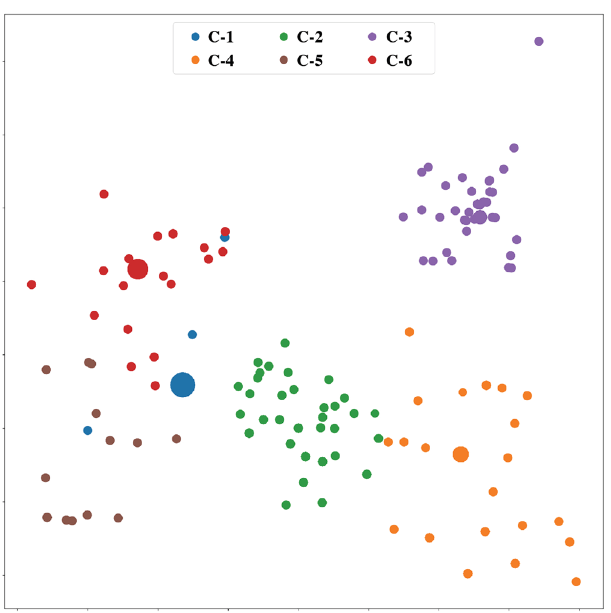
Figure 3. The clustering result of program embeddings. Each dot represents a program vector. The size of dots is proportional to the number of programs included in the same vector embeddings; six colors represent six challenges. Programs of the same challenge are grouped into the same category, while programs of different challenges are grouped into different